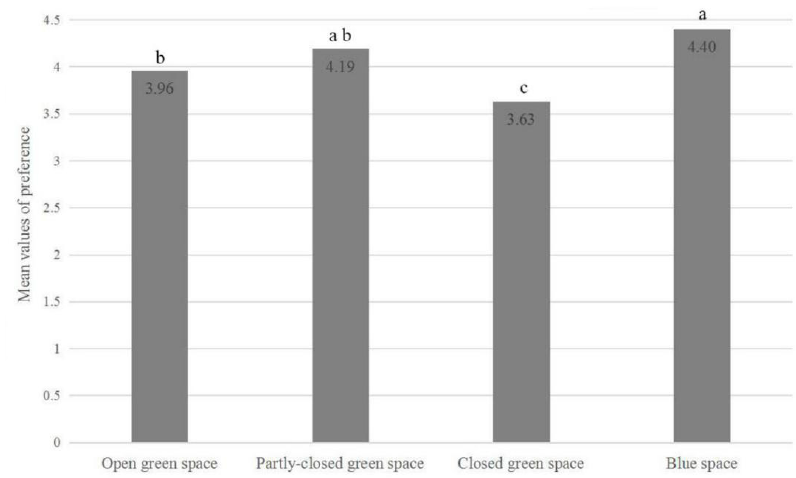
Figure 3. ANOVA with a post hoc test on differences in preference among the four study sites (significant difference at the 0.05 level is shown by different letters a, b and c).